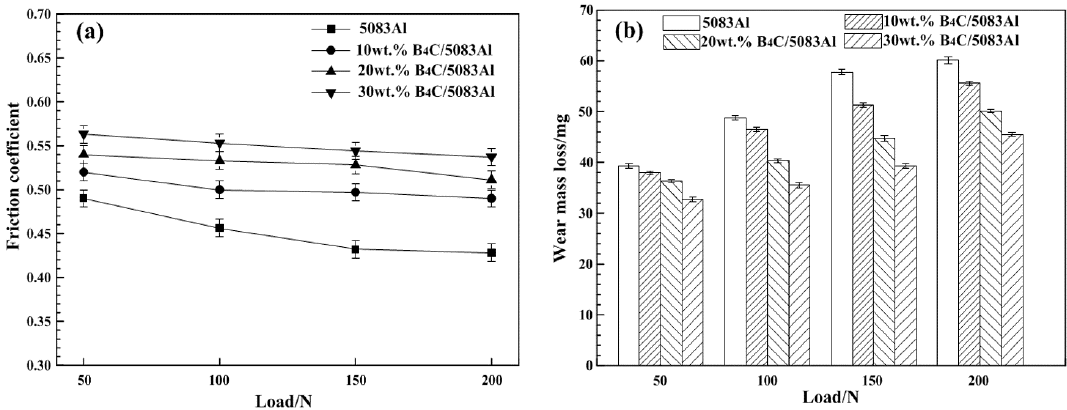
Figure 6. ( a ) Friction coefficient and ( b ) wear mass loss of Al matrix and B 4 C/Al 5083 composite under different applied loads.